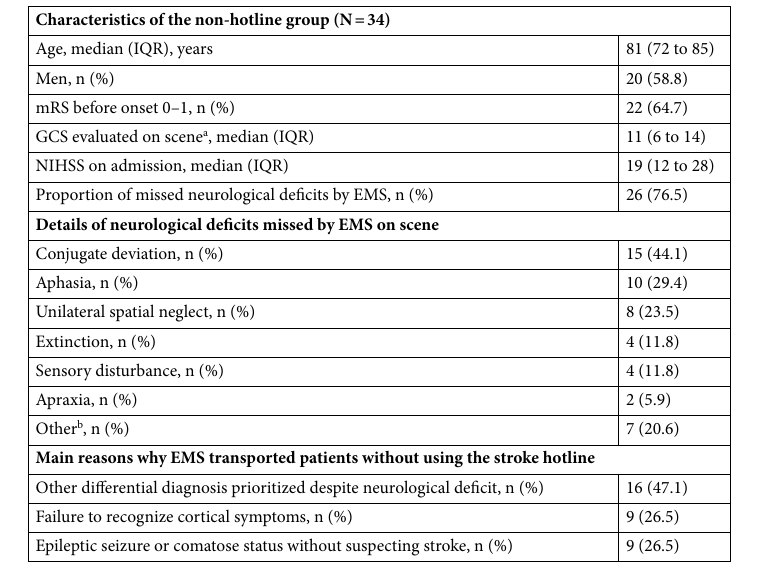
Table 4. Clinical characteristics of patients with large vessel occlusion who received endovascular therapy transported to the emergency department without the use of a stroke hotline. IQR interquartile range, mRS modified Rankin Scale, GCS Glasgow Coma Scale, NIHSS National Institutes of Health Stroke Scale, EMS emergency medical services. a Data were available for 31 patients. b Other neurological deficits included hemiplegia (5 cases), decerebrate posturing (1 case), and convulsion (1 case).